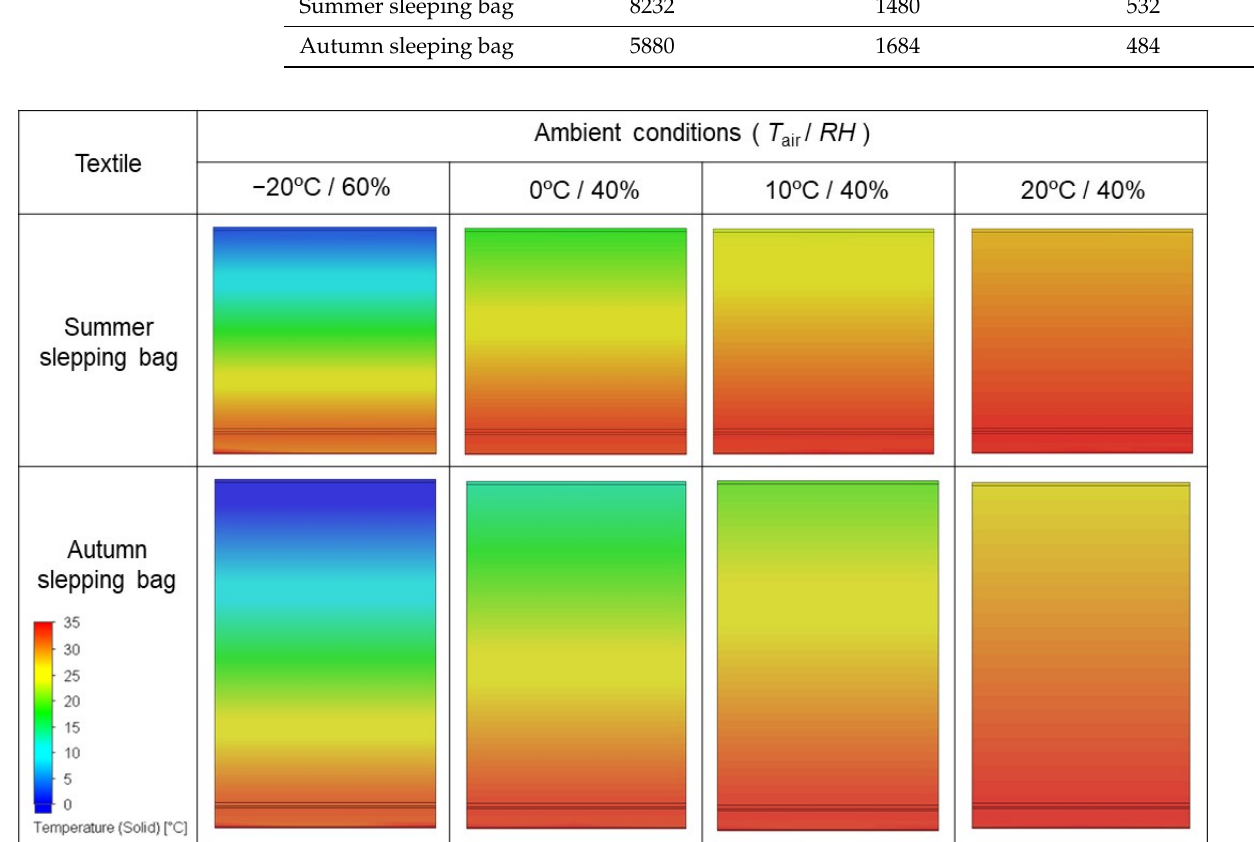
Figure 7. Temperature distributions on cross-sections of the tested sleeping bag models.